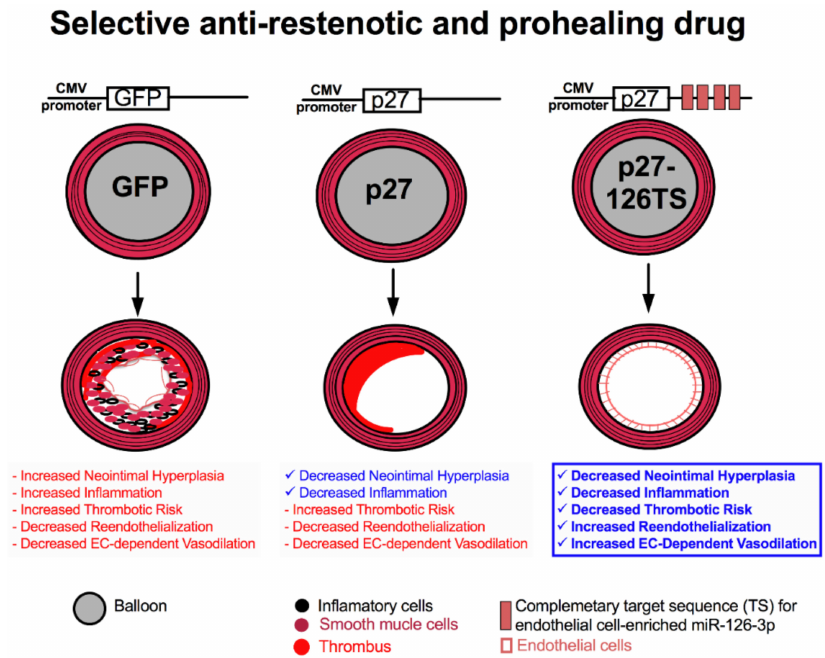
Figure 2. Graphic schematic depicting the cell-selective therapy capable of preventing restenosis and allowing for reendothelialization. Balloon injury and control green fluorescent protein (GFP) treated rat coronary artery results in neotintimal hyperplasia, infiltration of inflammatory cells, and an increased risk of thrombosis, accompanied by a severe reduction in reendothelialization and loss of endothelial cell-dependent vasodilation. Balloon injury and non-cell selective p27 treated rat coronary artery decreased neointimal hyperplasia and inflammation, but increased thrombosis due to decreased reendothelialization endothelial cell-dependent vasodilation. However, balloon injury and treatment with the cell-selective p27-126TS decreased neotintimal hyperplasia and inflammation, but also allowed for complete reendothelialization and effective endothelial cell-dependent vasodilation and greatly diminished the risk of thrombosis. EC: endothelial cell; CMV: